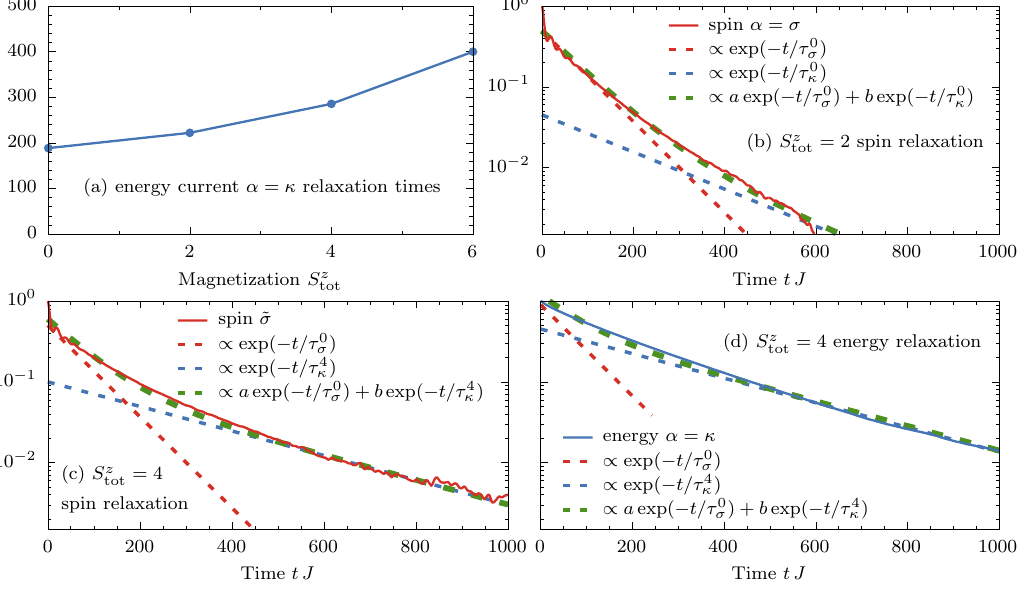
Figure 3: (a): Relaxation time for the energy current obtained from long-time fits marked by dashed lines in Fig. 2. (b,c): Continuous line shows spin-current C σ ( t ) = 2,4, respectively, while (d) energy-current C ( t ) for S z = 4. The results for S z κ tot tot in (b,d) are fitted by a sum of two exponential functions (dashed, green curves) with = τ 0 the relaxation times τ s as in panel (a), and τ s . Calculated for L = 28, ∆ = 0.5, κ σ σ and g =